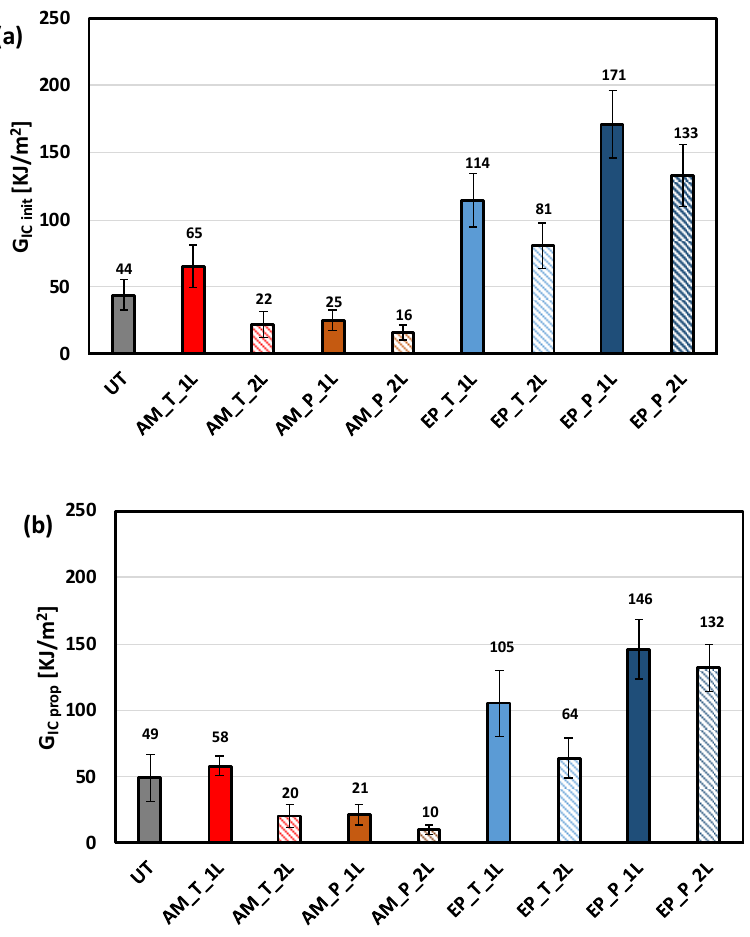
Figure 7. ( a ) G IC init and ( b ) G IC prop values obtained from DCB tests.